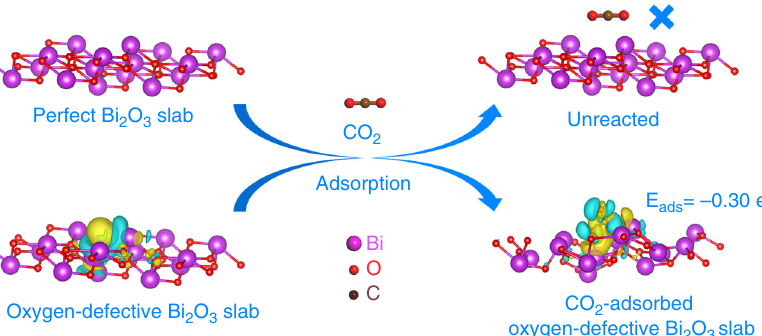
Fig. 1 Theoretical study. Schematic illustration of the adsorption of CO 2 molecules onto perfect and oxygen-defective Bi 2 O 3 single-unit-cell layer slab with the partial charge density of